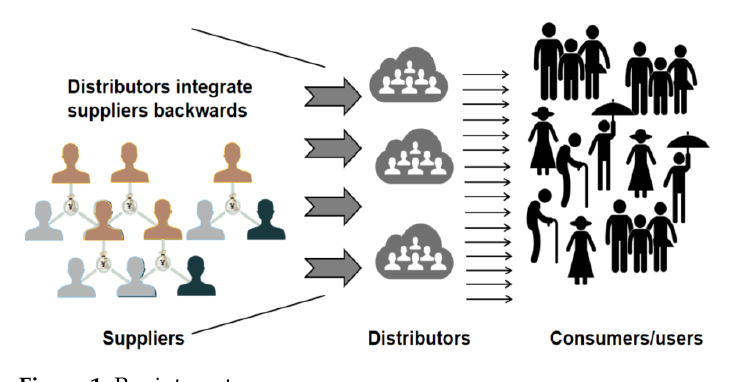
Figure 1. Pre-internet age.